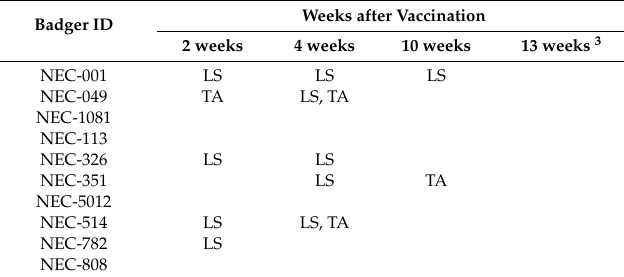
Table 7. Clinical samples from VES9 that yielded a positive Bacillus of Calmette and Gu é rin (BCG) culture 1 , derived from badgers that received the higher dose of BCG manually 2 . Badger ID Weeks after Vaccination 2 weeks 4 weeks 10 weeks 13 weeks 3 NEC-001 LS LS LS NEC-049 LS, TA NEC-1081